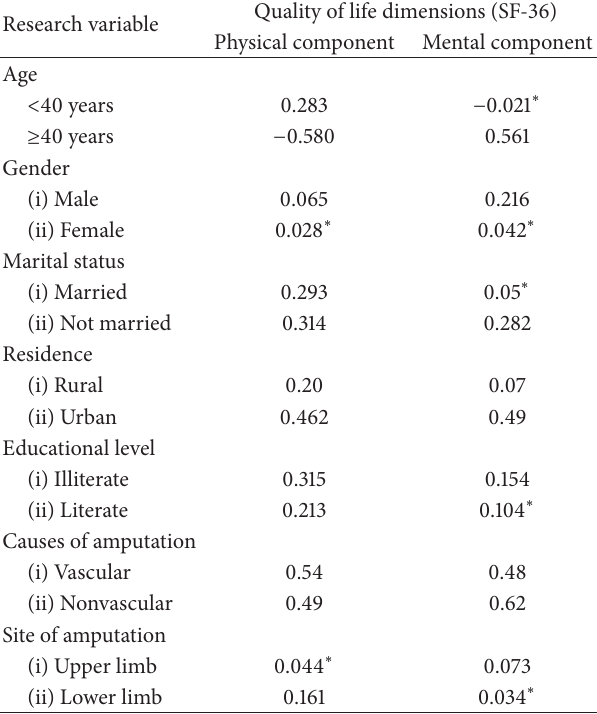
Table 4: Correlation of some research variables and dimensions of quality of life among